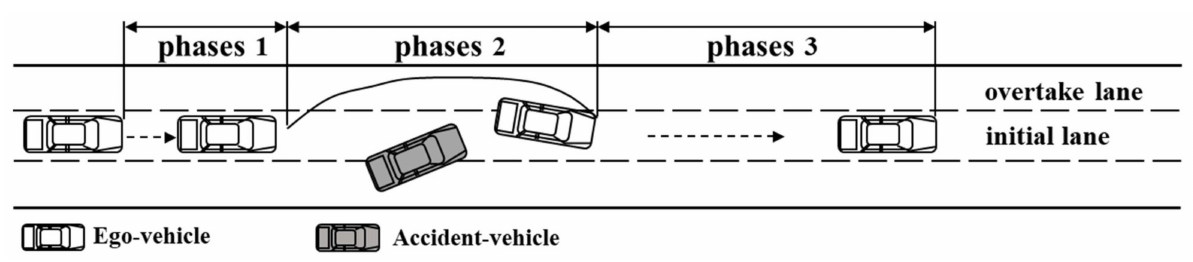
Figure 2. Schematic diagram of the entire process of taking over.